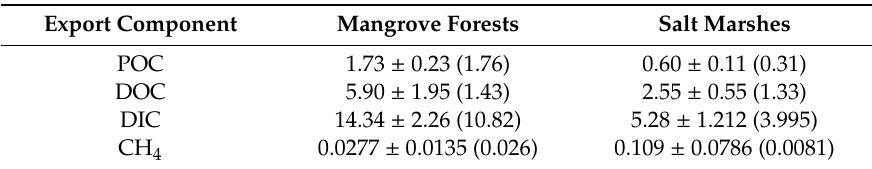
Table 5. Comparison of mean ( ± 1SE) rates of particulate organic carbon (POC), dissolved organic carbon (DOC), DIC and CH 4 export from mangrove and salt marsh ecosystems to adjacent tidal waters. Units = Mg C ha − 1 a − 1 . Median values are in parentheses. Mangrove data from [52,94,153–158]. Salt marsh data from